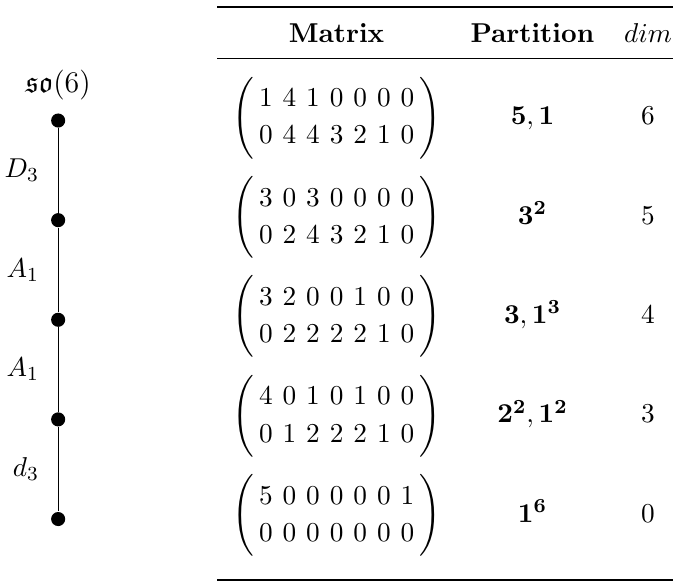
Table 13. Results obtained applying the matrix formalism to so